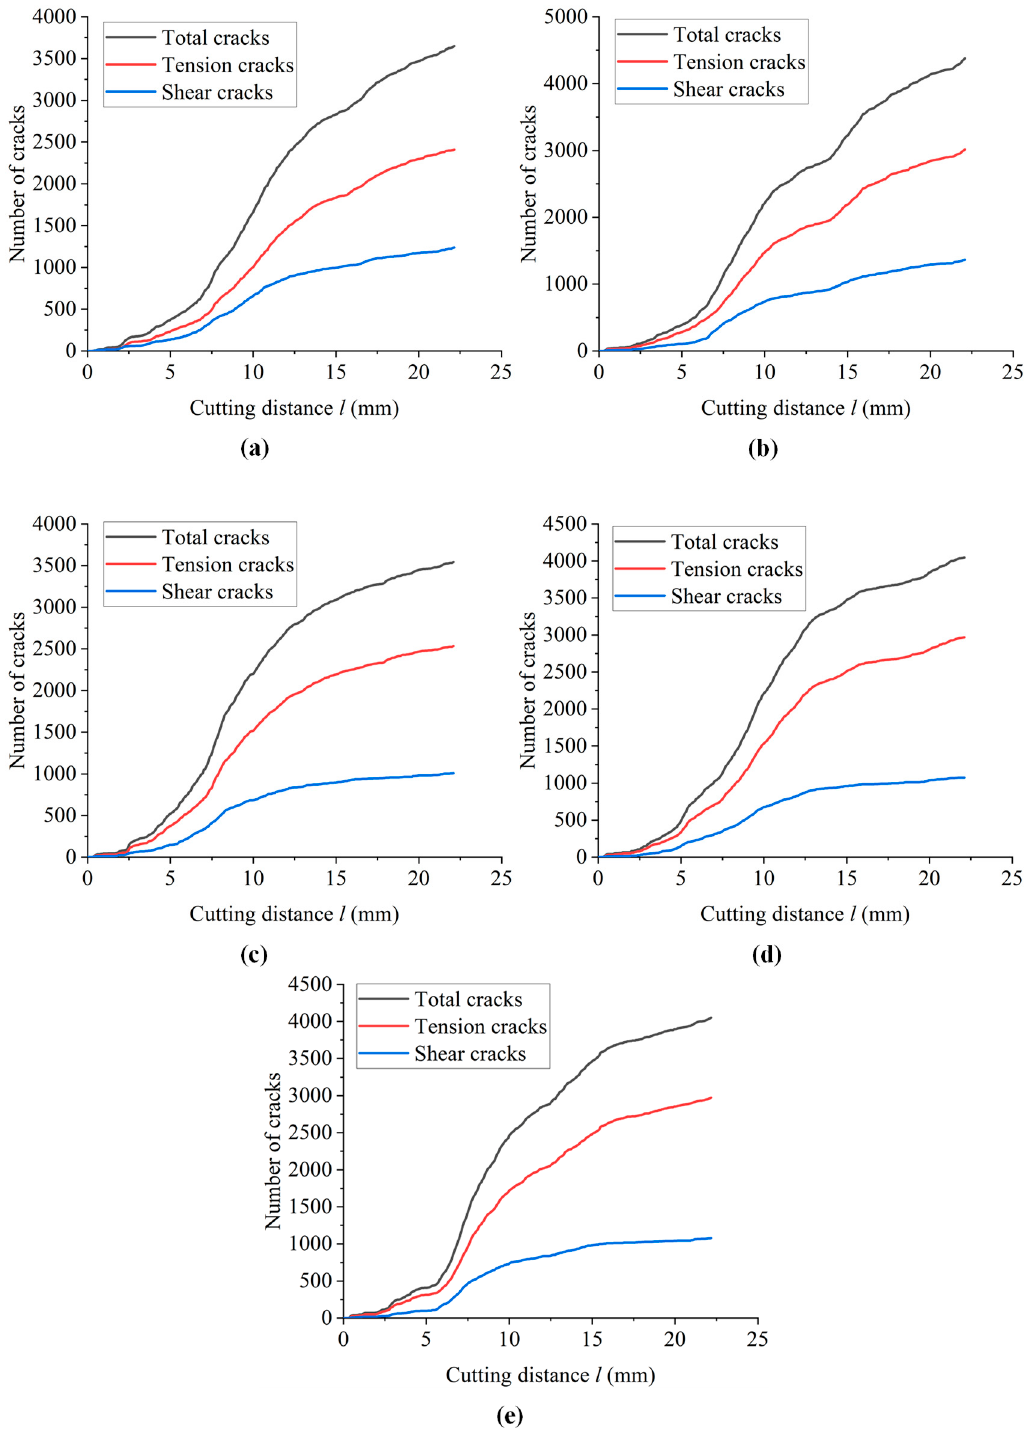
Figure 13. Variation characteristics of crack number of samples with different bedding thicknesses: ( a ) 2 mm; ( b ) 4 mm; ( c ) 6 mm; ( d ) 8 mm; ( e ) 10 mm.